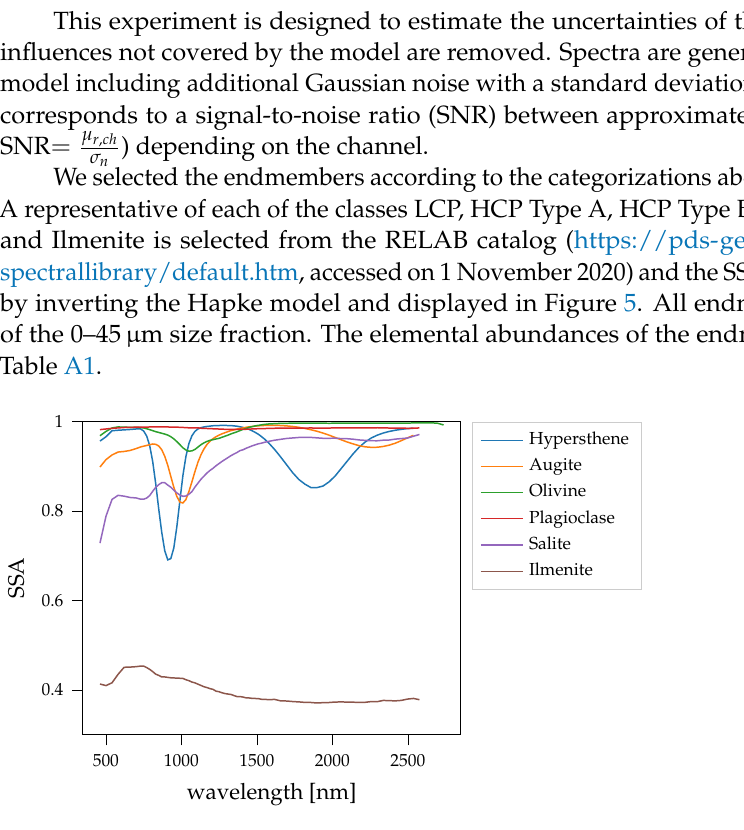
1.2 wt.%, respectively. Ultimately, 48 synthetic mixtures (mix 0 –mix 47 ) are created.